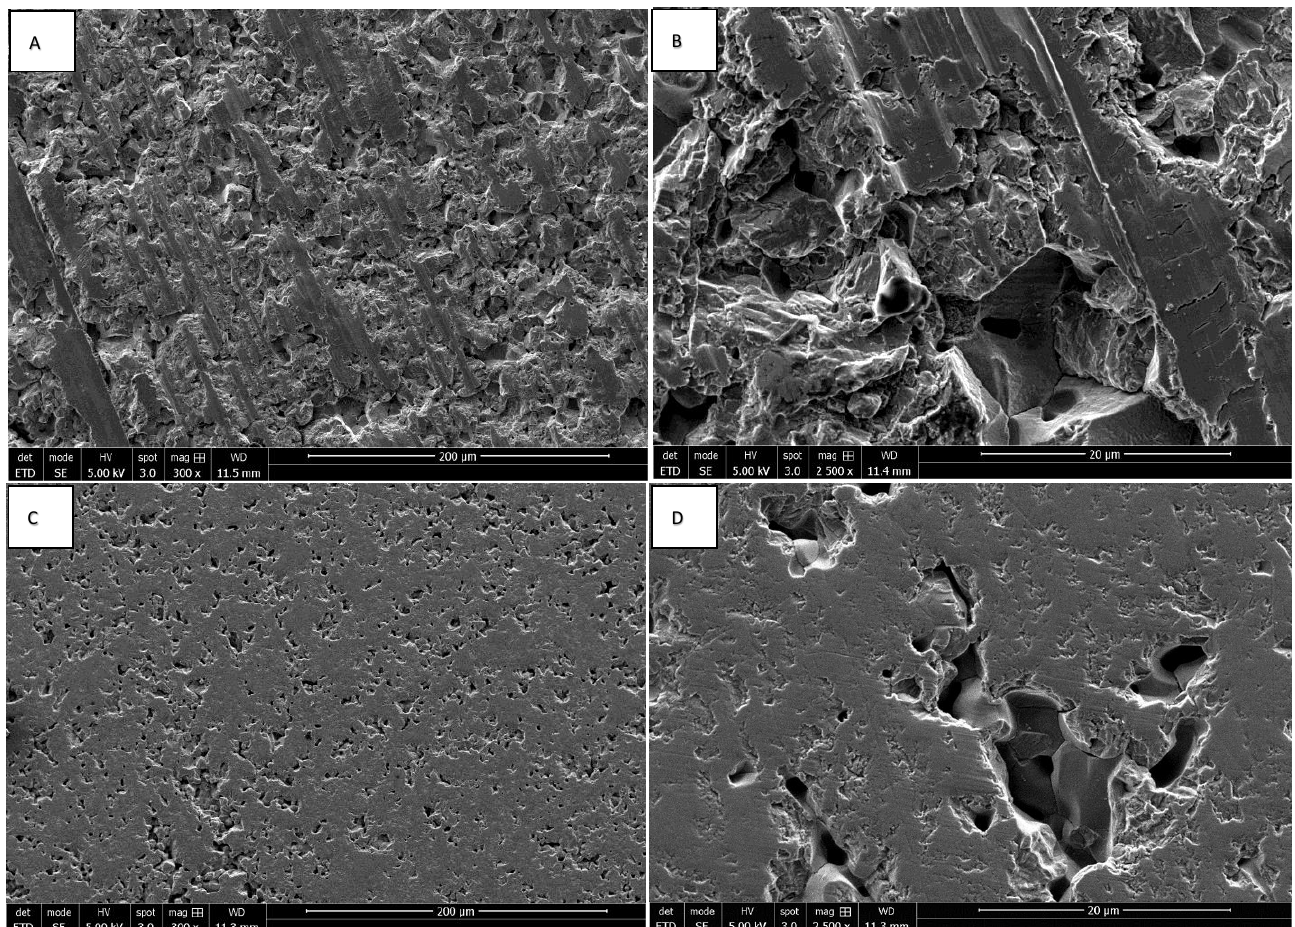
Figure 1. SEM images of rough (( A ) magnification 300×; ( B ) magnification 2500×) and smooth surfaces (( C ) magnification 300×; ( D ) magnification 2500×) of ZrO 2 discs.